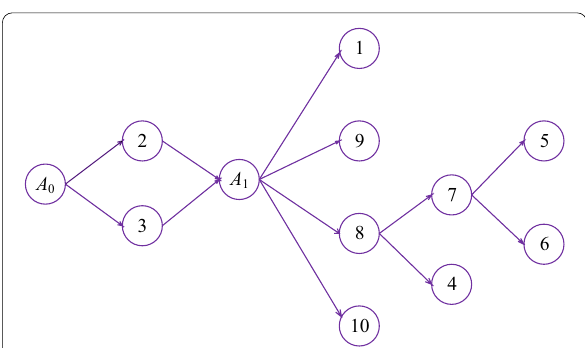
Figure 1 The task precedence relationships of one example